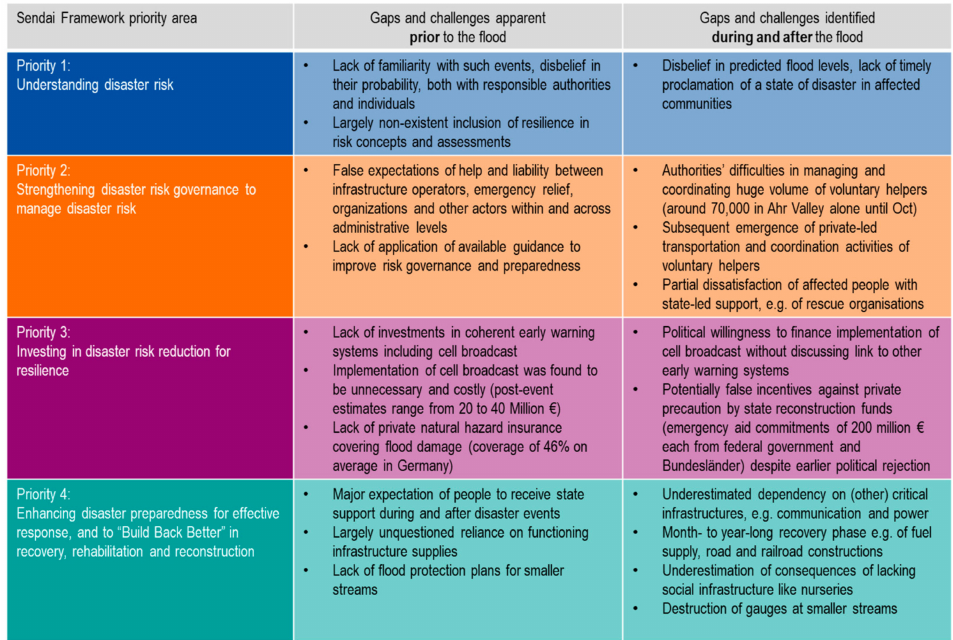
Figure 8. Lesson to learn gaps and challenges prior, during and after the flood 2021. Sources of the content: